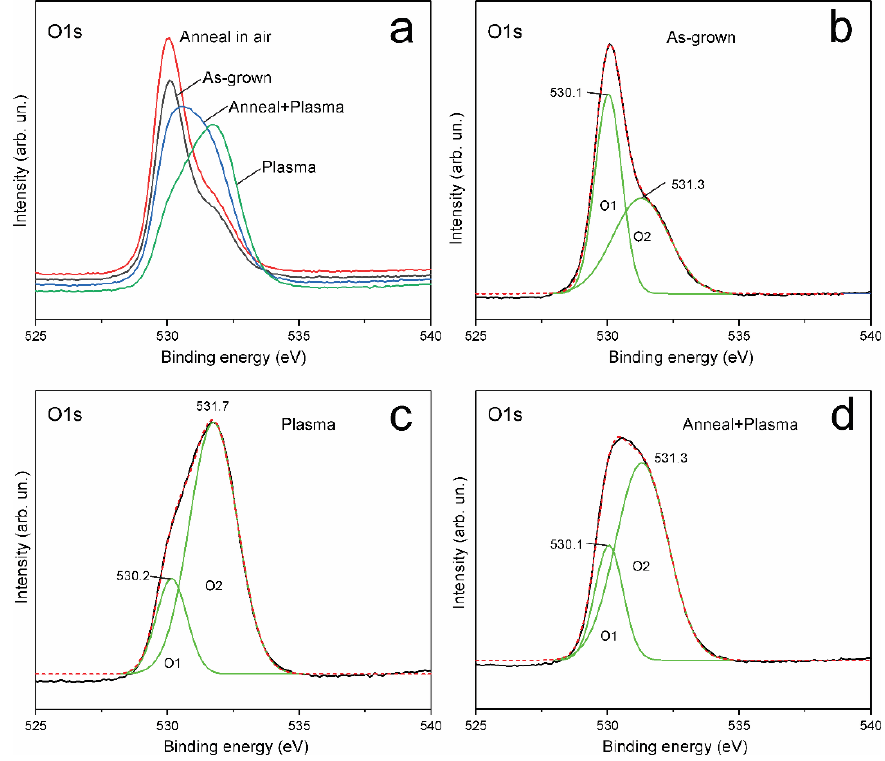
Figure 5. XPS spectra measured 6 days after plasma treatment: ( a ) XPS O1s spectra of AG, A, P and A + P samples; ( b – d ) XPS O1s spectra and deconvolution of the spectra (green lines) into two Gaussian peaks O1 and O2. The parameters of O1 and O2 peaks are given in Table 2; the dashed line corresponds to the sum of O1 + O2. Table 2. Parameters of XPS O1s spectra of AG, A, P and A + P